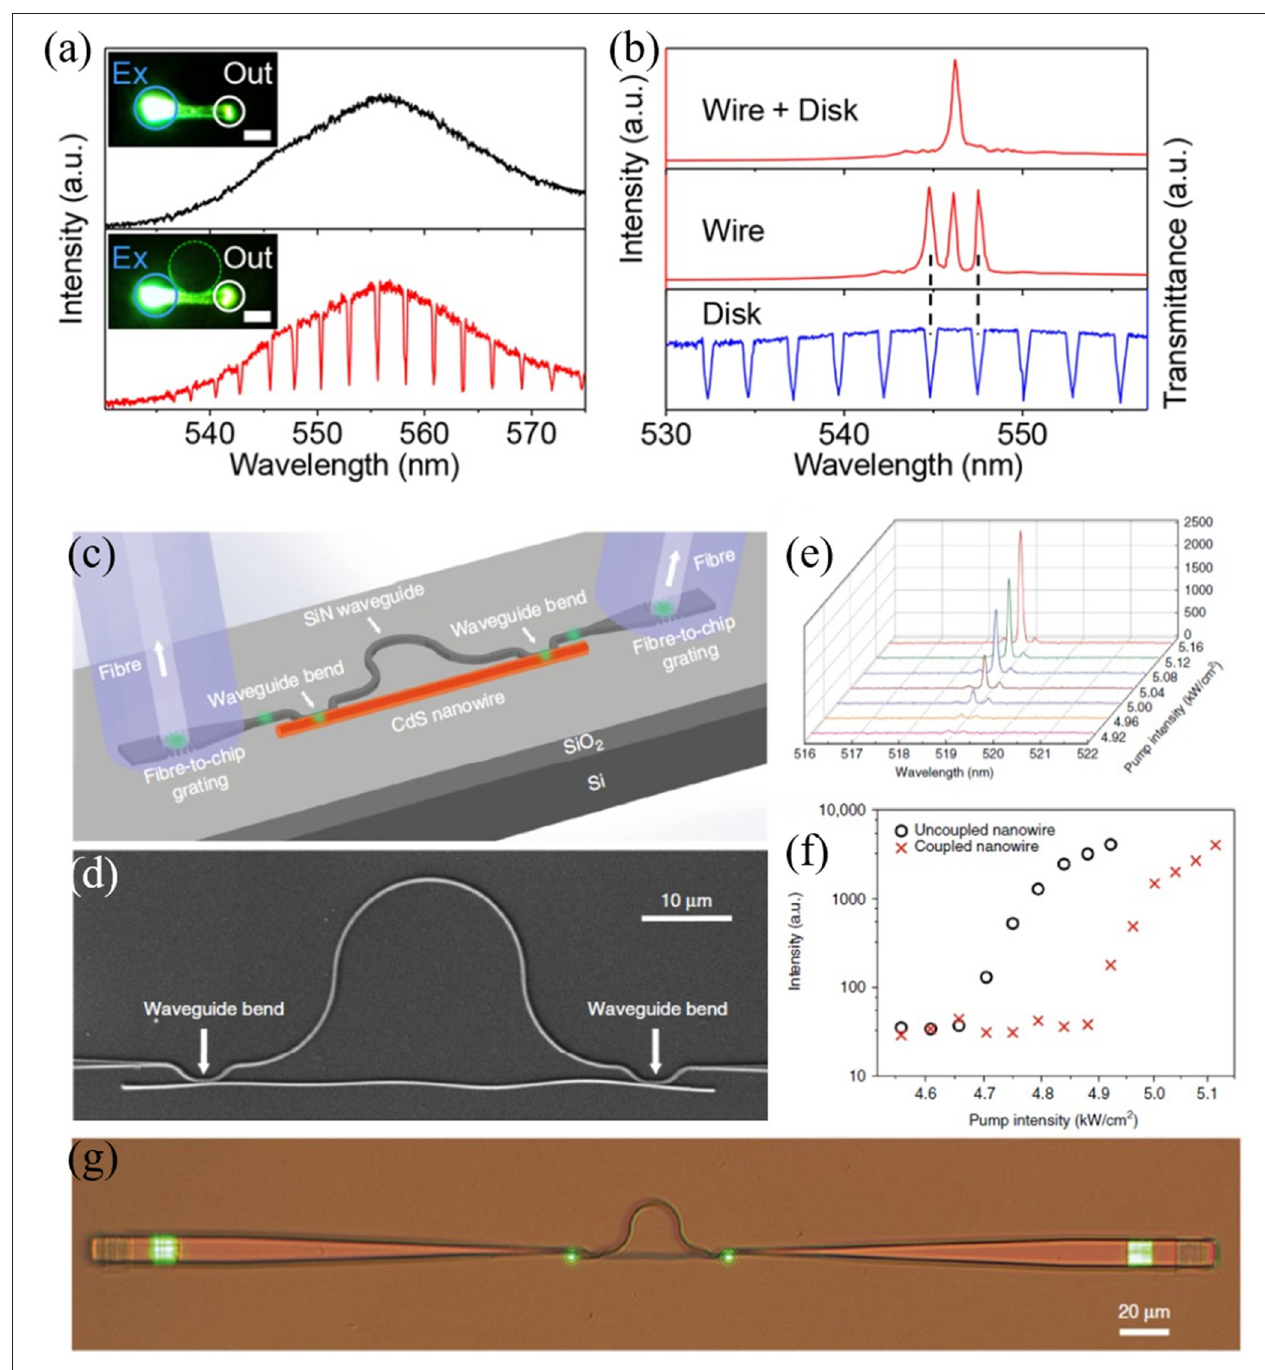
FIGURE 10 | (a) Original and modulated PL spectra from perovskite nanowire and microdisk coupled nanowire. Insets show the microscope images. (b) Schematic of the mode selection effect in the nanowire-microdisk system. (c) Schematic diagram and (d) SEM image of the hybrid MZI structure. (e) Lasing spectra obtained at different pumping intensities above the threshold. (f) Dependence of the lasing output on the pumping intensity of the excited CdS nanowire for the coupled (red) and uncoupled (black) cases. (g) Optical image of the hybrid MZI structure under excitation. (a,b) Reproduced with permission. Zhao et al. (2018) Copyright 2018, American Chemical Society. (c–g) Reproduced with permission. Bao et al. (2020) Copyright 2020, Nature Publishing